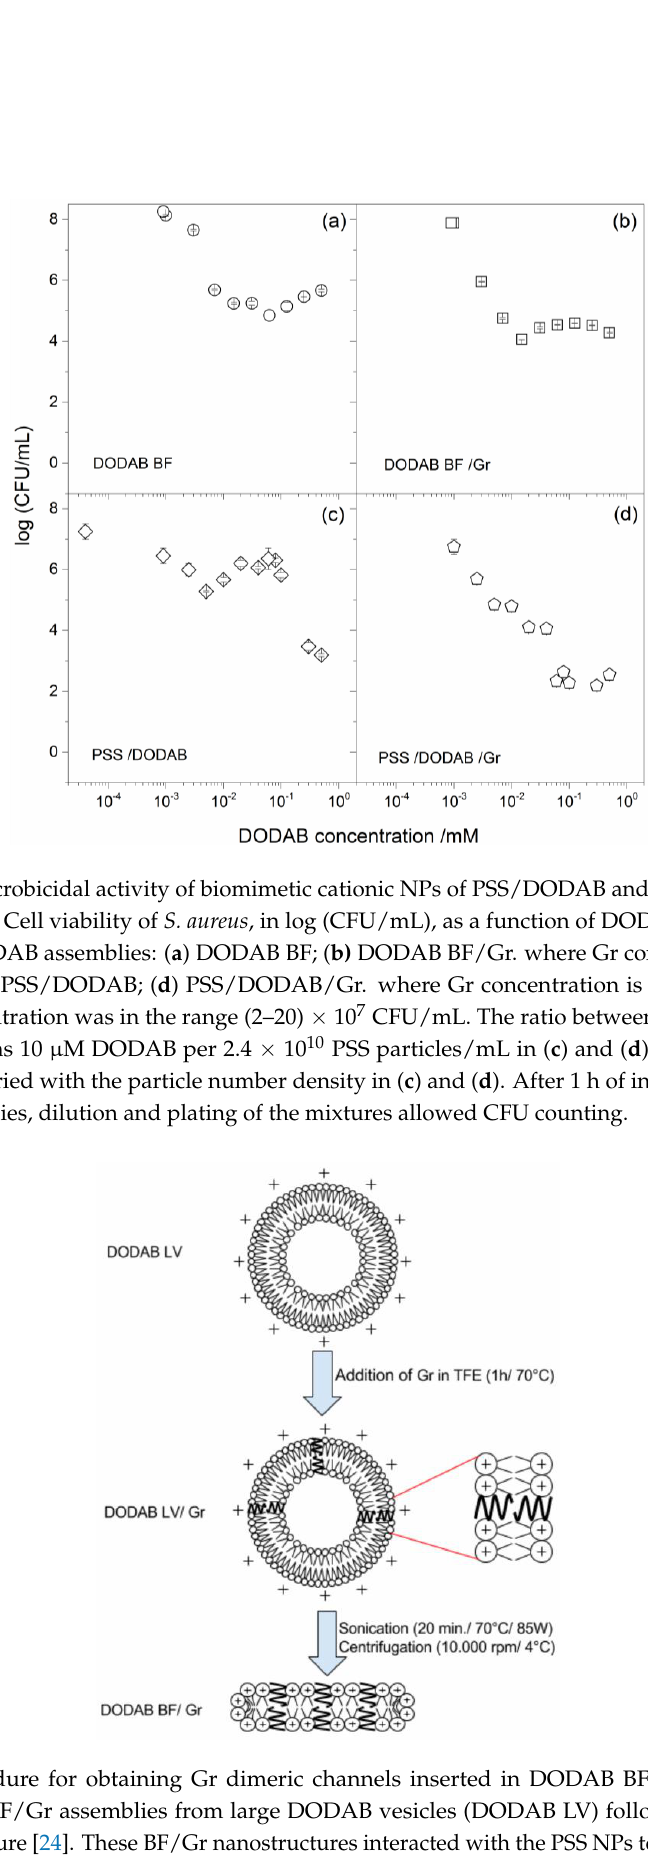
of the DODAB BF/Gr assemblies from large DODAB vesicles (DODAB LV) followed a previously described procedure [24]. These BF/Gr nanostructures interacted with the PSS NPs to yield the cationic biomimetic particles with the microbicidal properties described in this